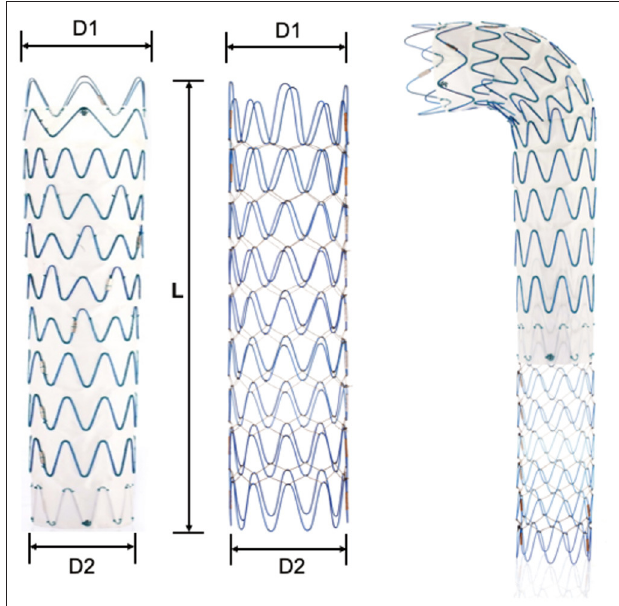
FIGURE 1 | Illustration of the Fabulous system. Fabulous consists of the proximal stent graft and the distal bare stent. D1, the proximal diameter. D2, the distal diameter. L, the length of the stent. Both components are available in 13 sizes (D1) and in tapered and non-tapered configurations (D1-D2).